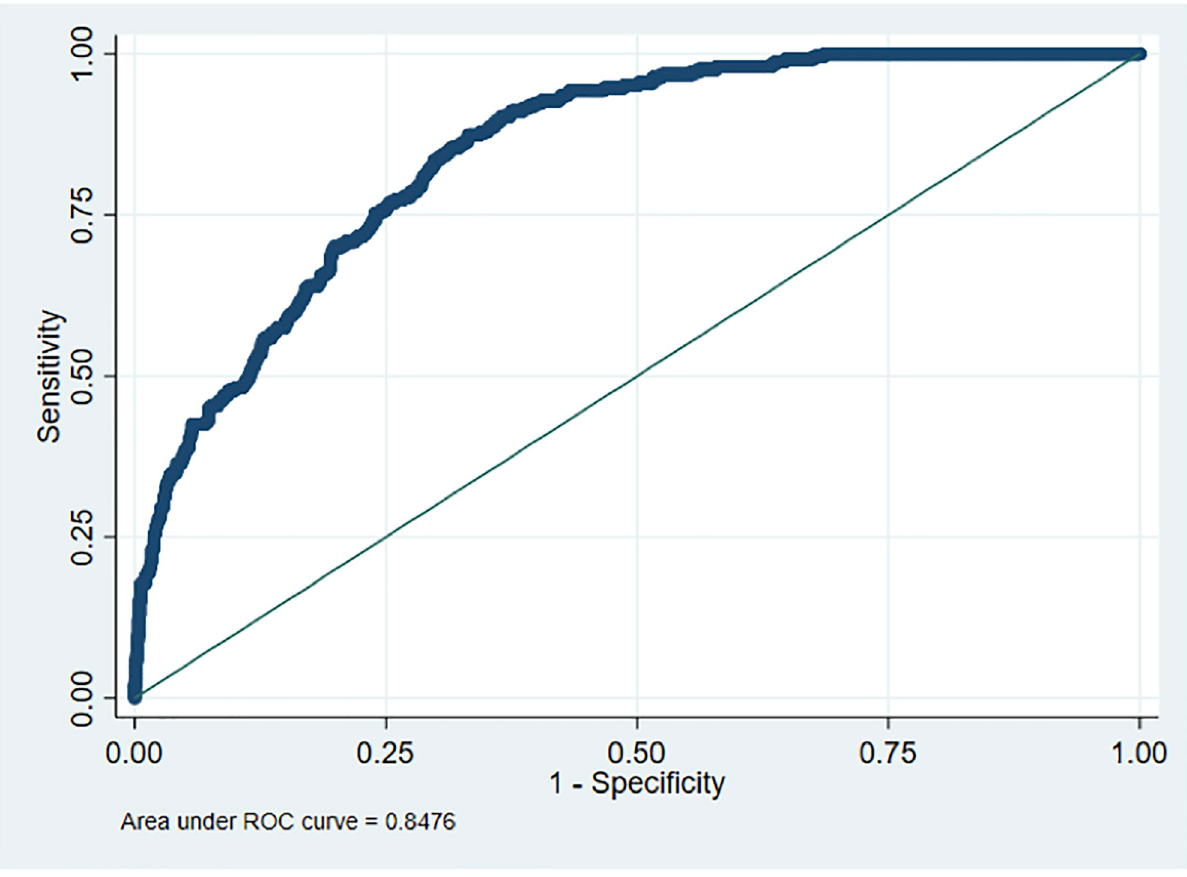
Fig 2. ROC curve for real-time validation (n =